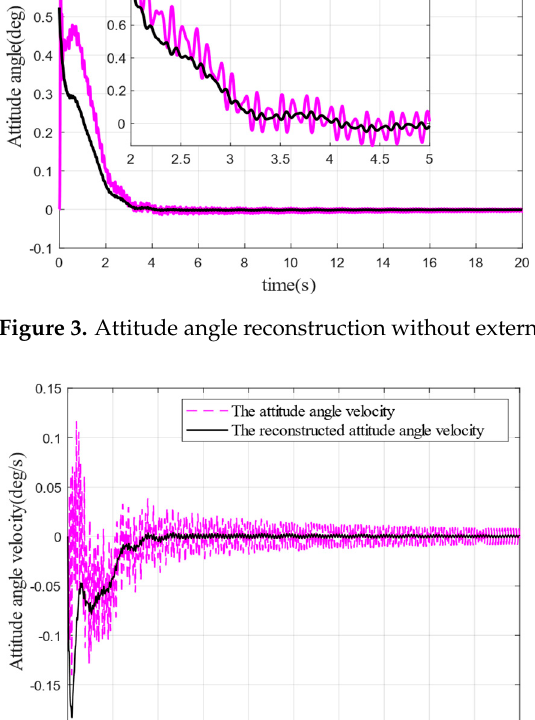
Figure 5. First ‐ order elastic vibration mode without external interference.